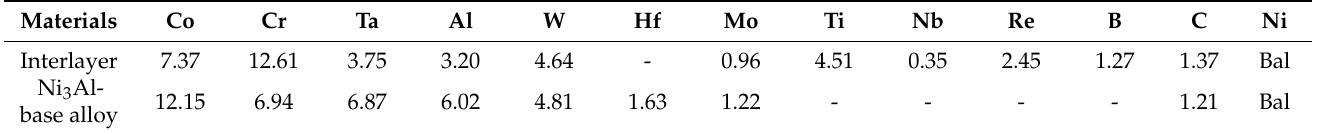
Table 1. Chemical compositions of powder interlayer and Ni 3 Al base material